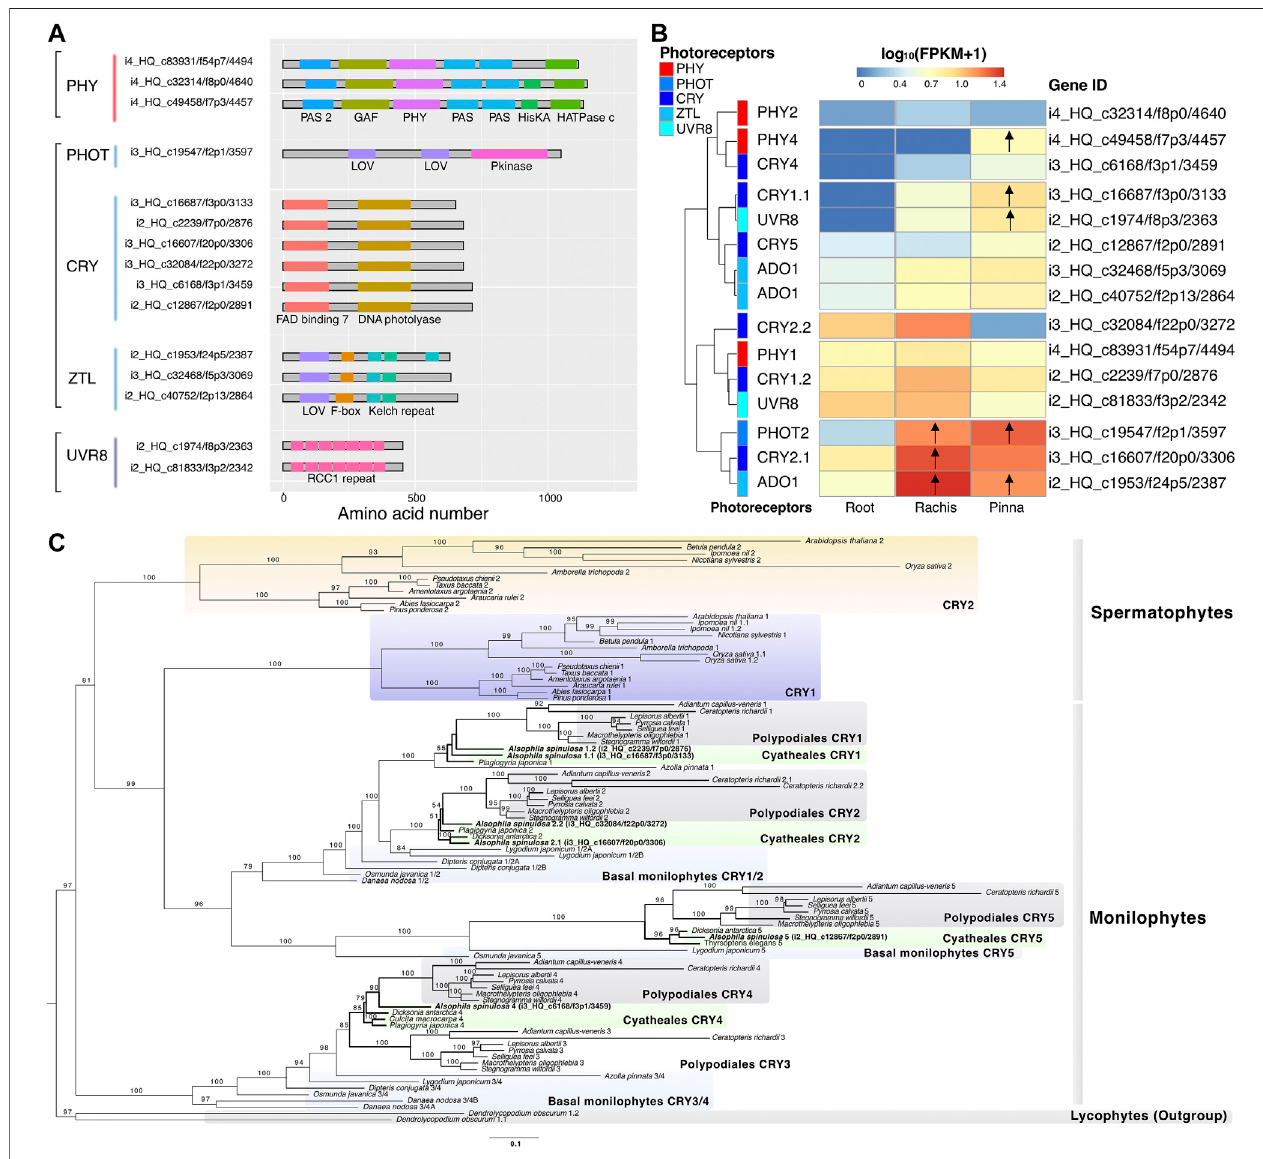
FIGURE5| Characterizationofphotoreceptorgenesandphylogeneticanalysisof CRY . (A) Thetypicalproteindomainidenti fi edin fi vetypesofphotoreceptors. (B) Heatmap represents the expression pattern of the photoreceptors in three organs. Arrows indicate the upregulated genes compared to their expression in the root. (C) The CRY phylogenetic tree of spermatophytes, monilophytes, and lycophytes constructed by maximum likelihood method. The number above the nodes indicates the bootstrap value, which was omitted if it was less than 50.